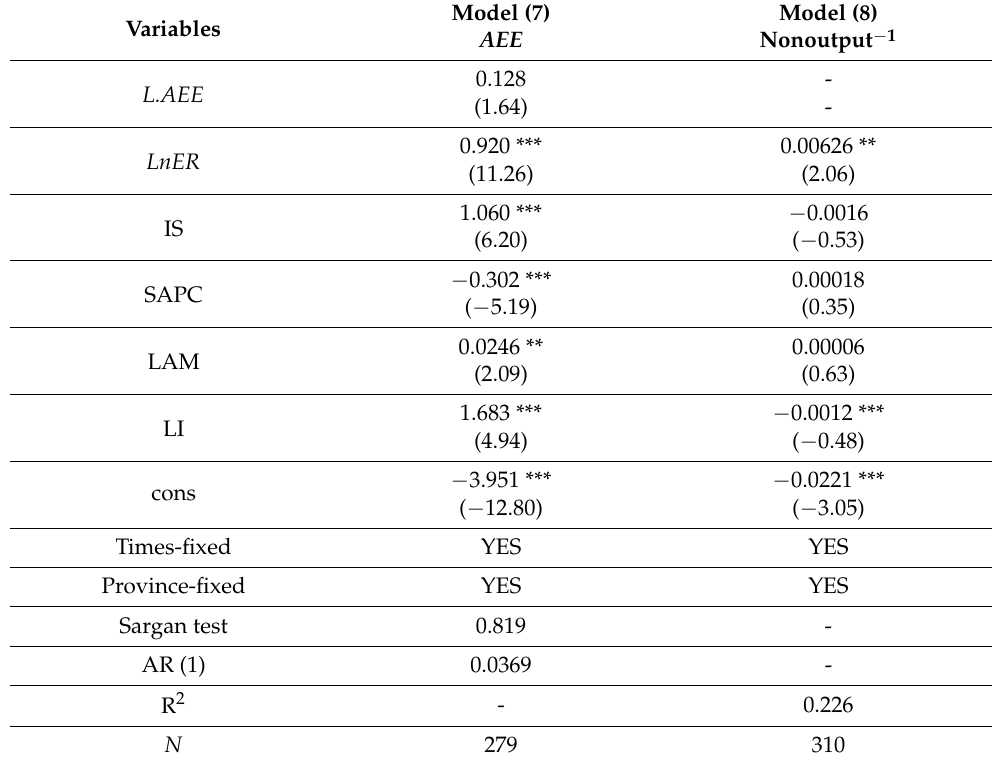
Table 4. Robustness